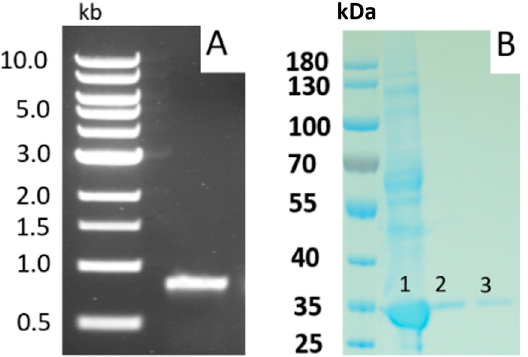
Figure 5. NK gene product and insoluble (inclusion-body) NK protein in Escherichia coli . ( A ) PCR-derived NK gene product from B. subtilis (natto); ( B ) Lane 1: NK protein present in crude medium extract; Lane 2 and 3: NK protein purified using a Ni-NTA (nickel-charged affinity nitrilotriacetic acid) column.